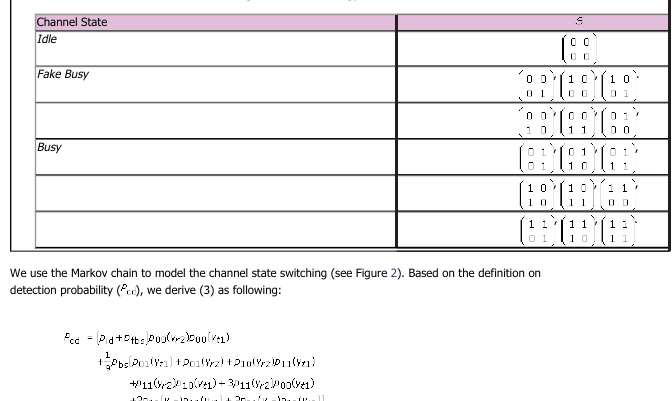
Figure 2 The Markov Chain for channel state switching for ideal energy